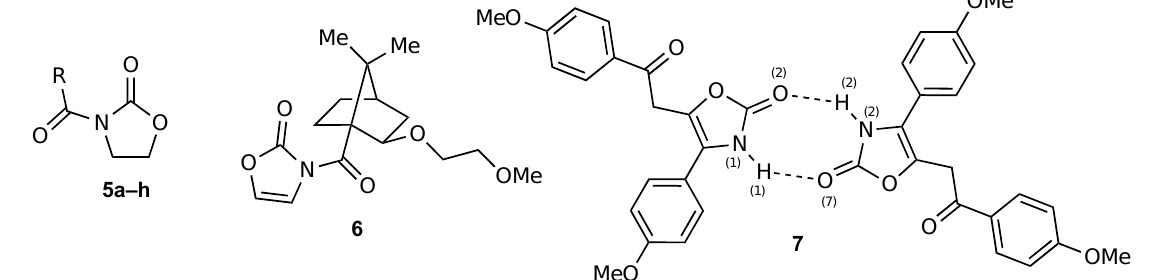
Figure 2. Structures of comparison compounds 5 , 6 and 7 .